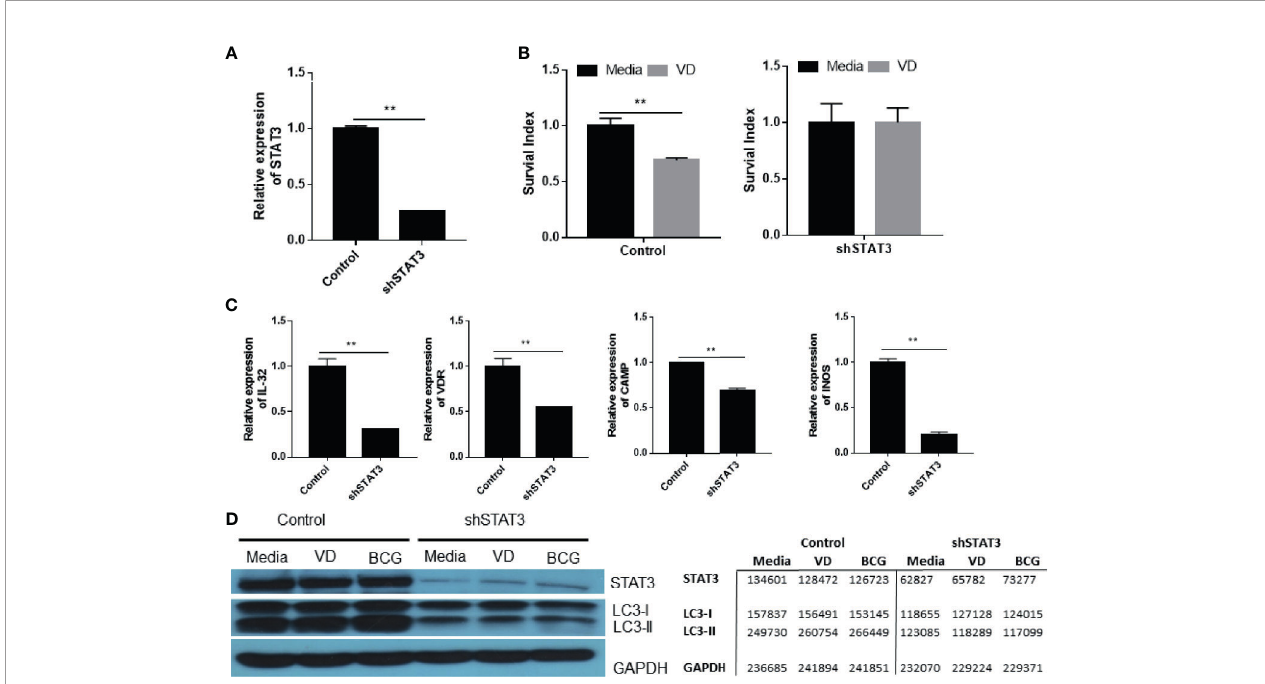
FIGURE 4 | STAT3 down-regulation depressed diverse antimicrobial activities involving VDR-related CYP27B1, DEFB4A and CAMP pathways as well as IL-32, iNOS and autophagy mechanisms, and led to an enhanced mycobacterial infection. (A) shows STAT3 down-regulation in A549 cells after transfection with the plasmid encoding STAT3 shRNA. (B) shows that the Vitamin D (VD) treatment of BCG-infected A549 cells transfected with plasmid control mediated inhibition of BCG growth (left panel), whereas STAT3 down-regulation in A549 cells transfected with the shRNA reduced the VD-mediated inhibition of BCG infection (right panel). Shown was the percentage growth index representing intracellular bacteria survival calculated as follows: Growth Index = 100 × CFU of treatment/CFU of media. (C) shows that STAT3 down-regulation by the shRNA transfection into A549 decreased expressions of gene encoding IL-32, VDR, CAMP, and iNOS during BCG infection, compared with controls. (D) shows representative results in Western blot (WB) indicating that STAT3 down-regulation by the shRNA indeed reduced protein expressions of STAT3, IC3 I and II in the settings of media control, VD treatment and BCG infection, respectively. The values of band densities in WB fi gure were measured by ImageJ software and shown in right. Data are means ± standard errors. **P <